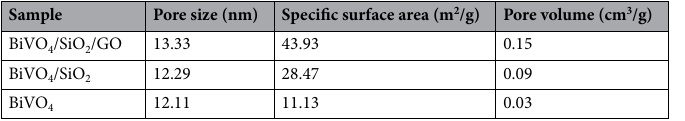
Table 1. Surface properties of as–prepared photocatalysts.